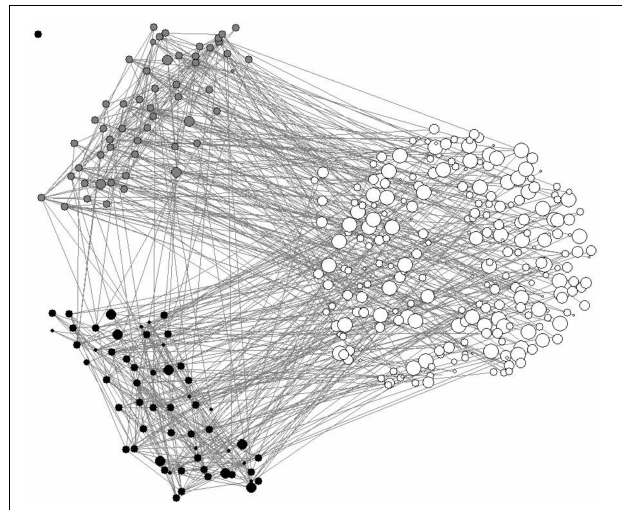
FIGURE 1 | External and internal learning and teaching network (size nodes based upon management